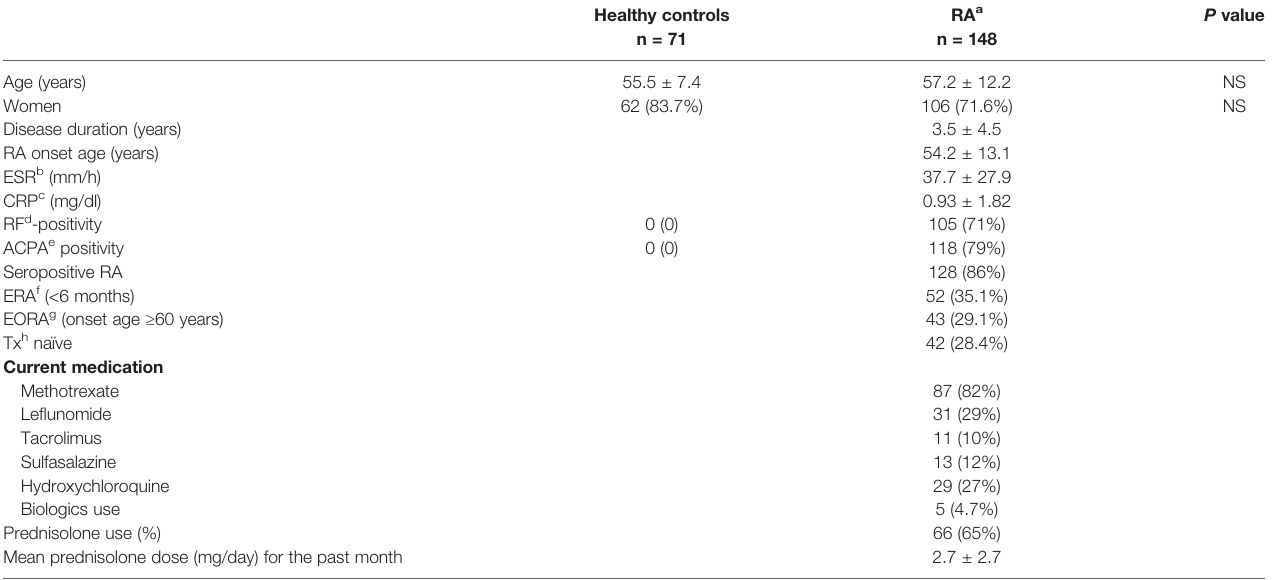
TABLE 1 | Clinical and laboratory fi ndings in healthy controls and RA patients.